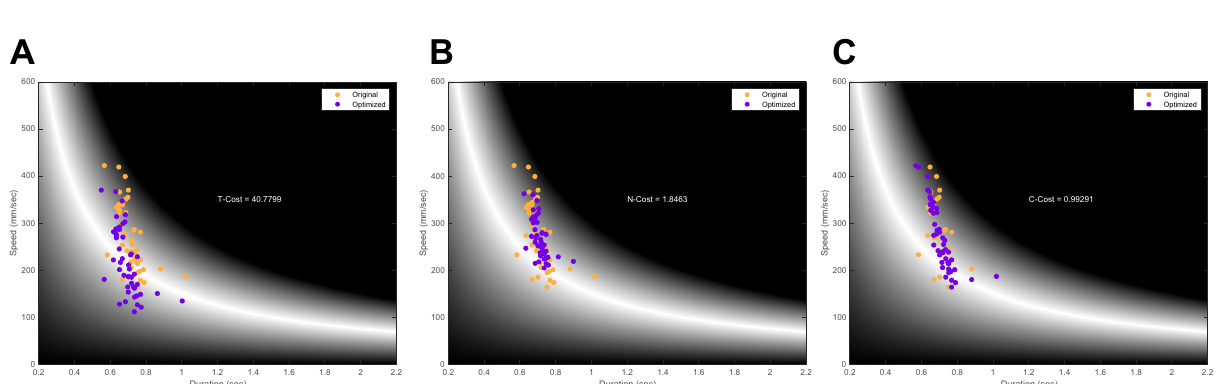
Figure 3. TNC-cost. Example for the calculation of the TNC-Cost for taken from a single subject throughout the performance. Each dot represents a single revolution performed; colors correspond to the original data (orange) compared to the optimized data (purple). ( A ) It is possible to see that for T-Cost, the entire data set was shifted to the location within the execution space that provided the best mean solution, while maintaining dispersion of data. ( B ) For the N-Cost, the data remained in the same location but the dispersion was minimized to the point which provided the best overall solution. ( C ) C-cost was calculated as the best possible combination of the actual performed values compared the original